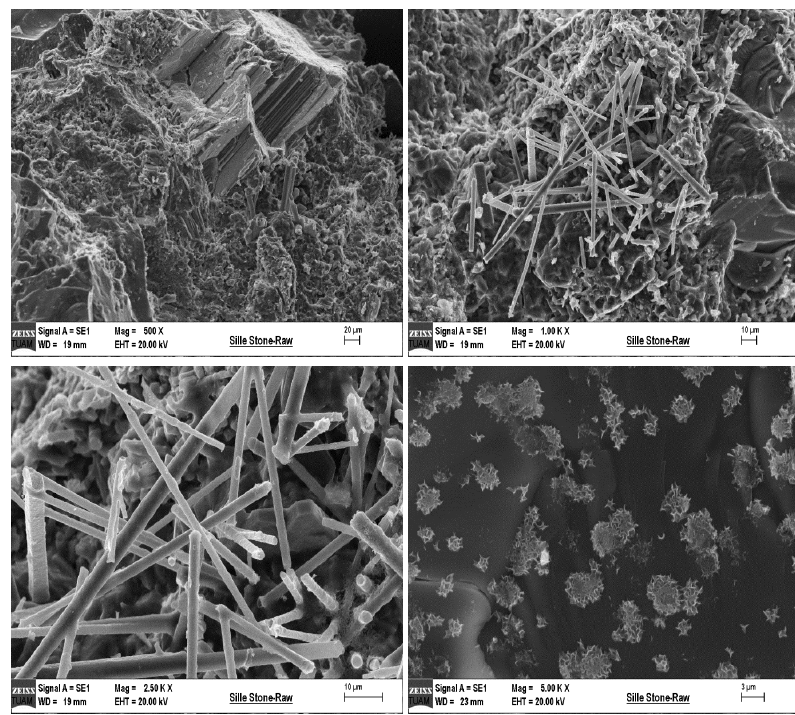
Figure 7. SEM micrographs of raw Sille stone Figure 7: SEM micrographs of raw Sille stone.